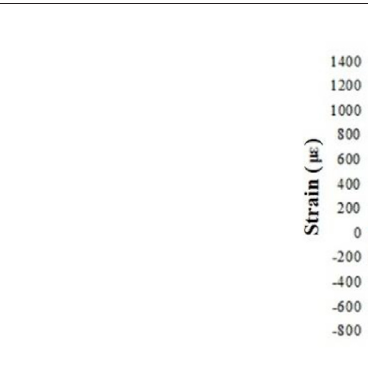
FIGURE 4 | Time-history curve of the radial strain of each layer during simultaneous blasting of Nos 1, 2, and 3.